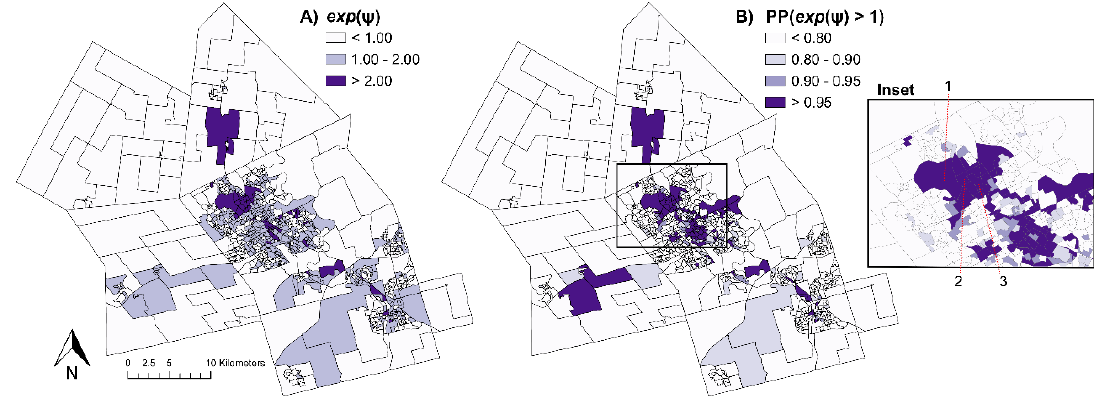
Figure 8. For 02:00–03:59, ( A ) space-time interaction and ( B ) space-time hotspot probability.